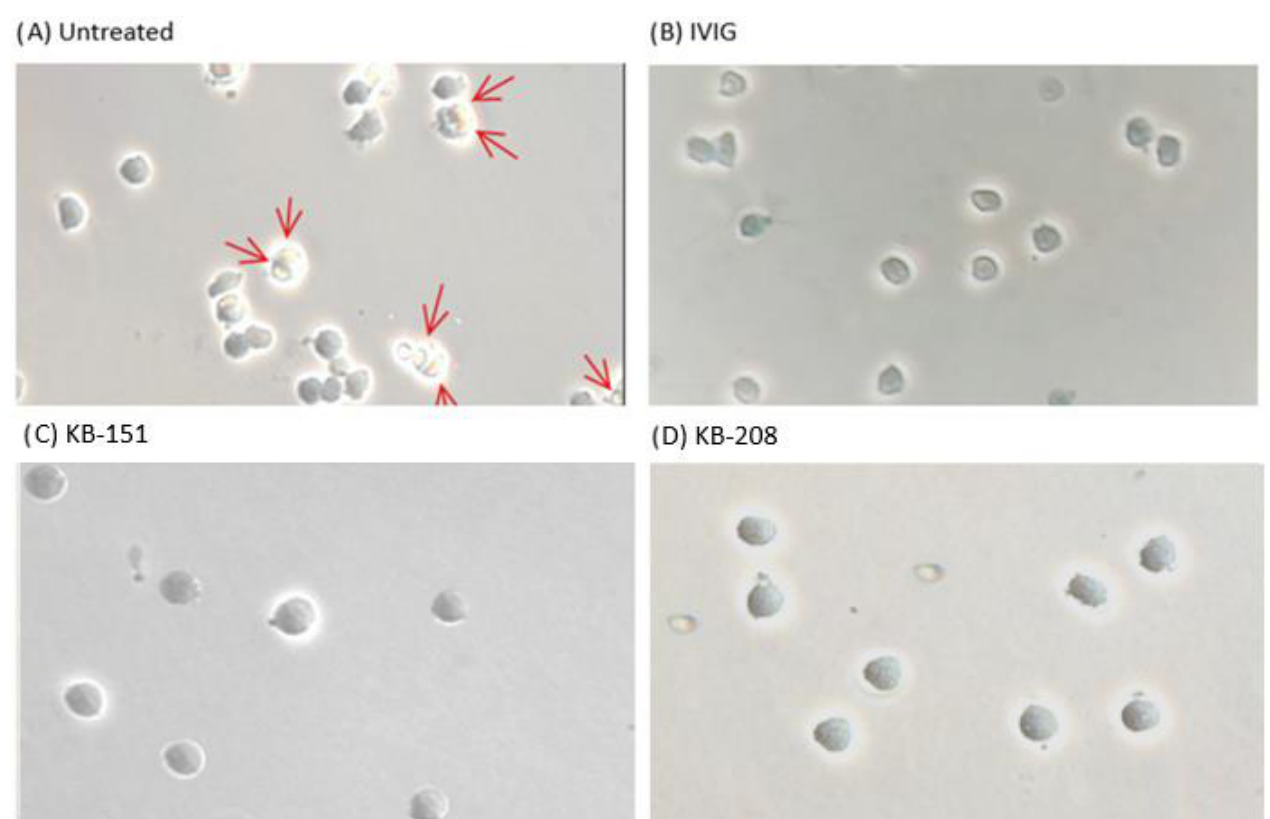
Figure 3. Phase contrast microscopy images. ( A ) Untreated human monocytes- representing mono- cytes phagocytosing RBCs opsonized with anti-D. Red arrows indicate RBCs that are phagocytosed (RBCs inside of monocytes). ( B ) Inhibitor control- Human monocytes treated with 1 mg/mL of IVIG. ( C ) Human monocytes treated with 100 µM KB-151. ( D ) Human monocytes treated with 100 µM KB-208. Table 1. Compounds that inhibited anti-D- opsonized Rh(D+) by ≥ 40% phagocytic inhibition.